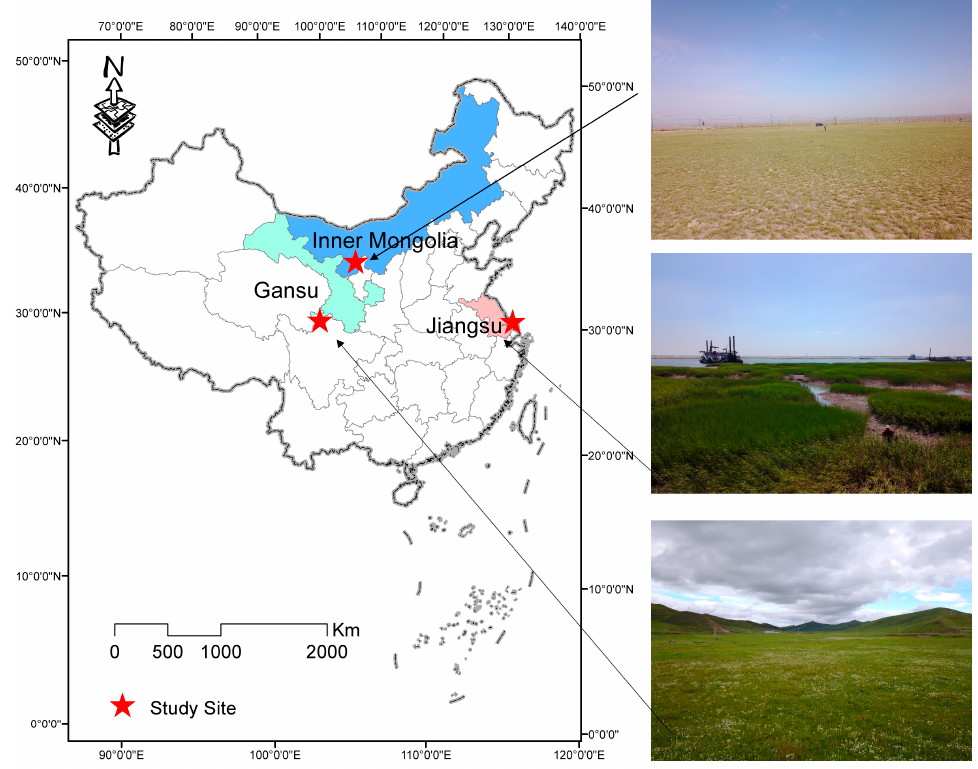
Figure 1. The location of study sites.